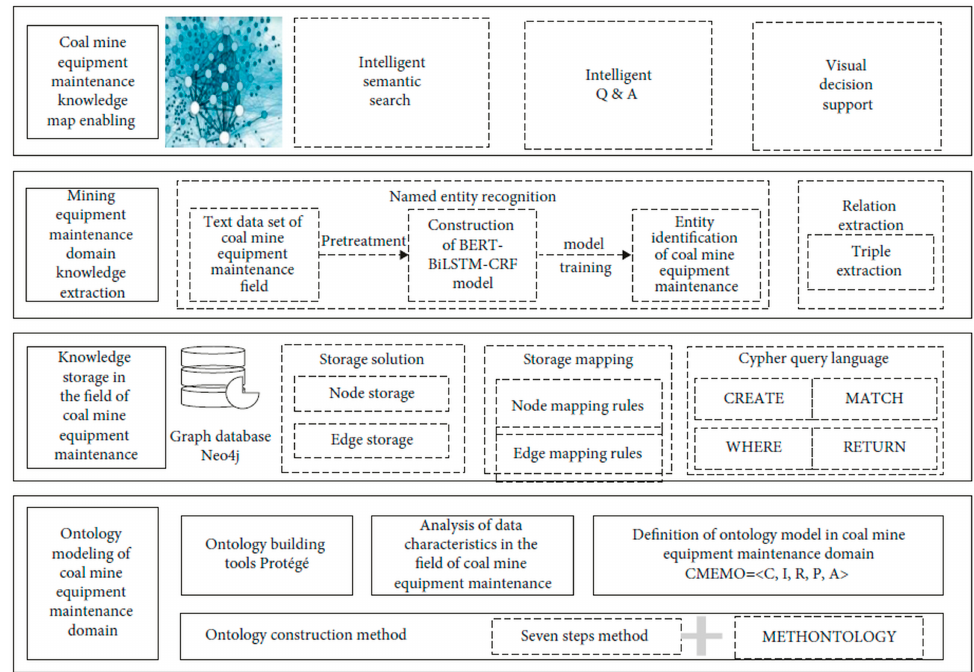
Figure 5. Architecture of the knowledge graph system for coal mine equipment maintenance (Reprinted from Ref. [42]).